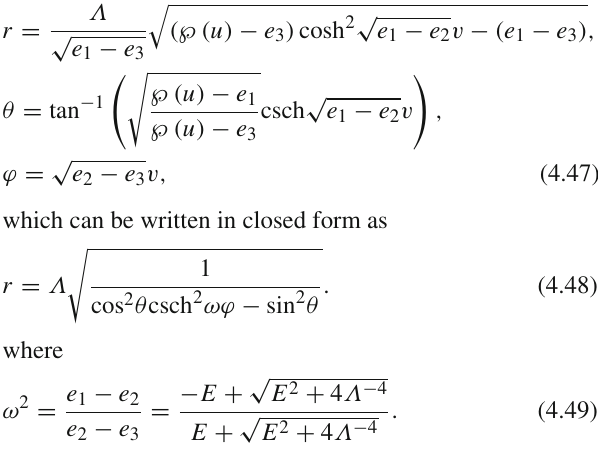
Fig. 7 The helicoid minimal surface in global and Poincaré coordi- nates